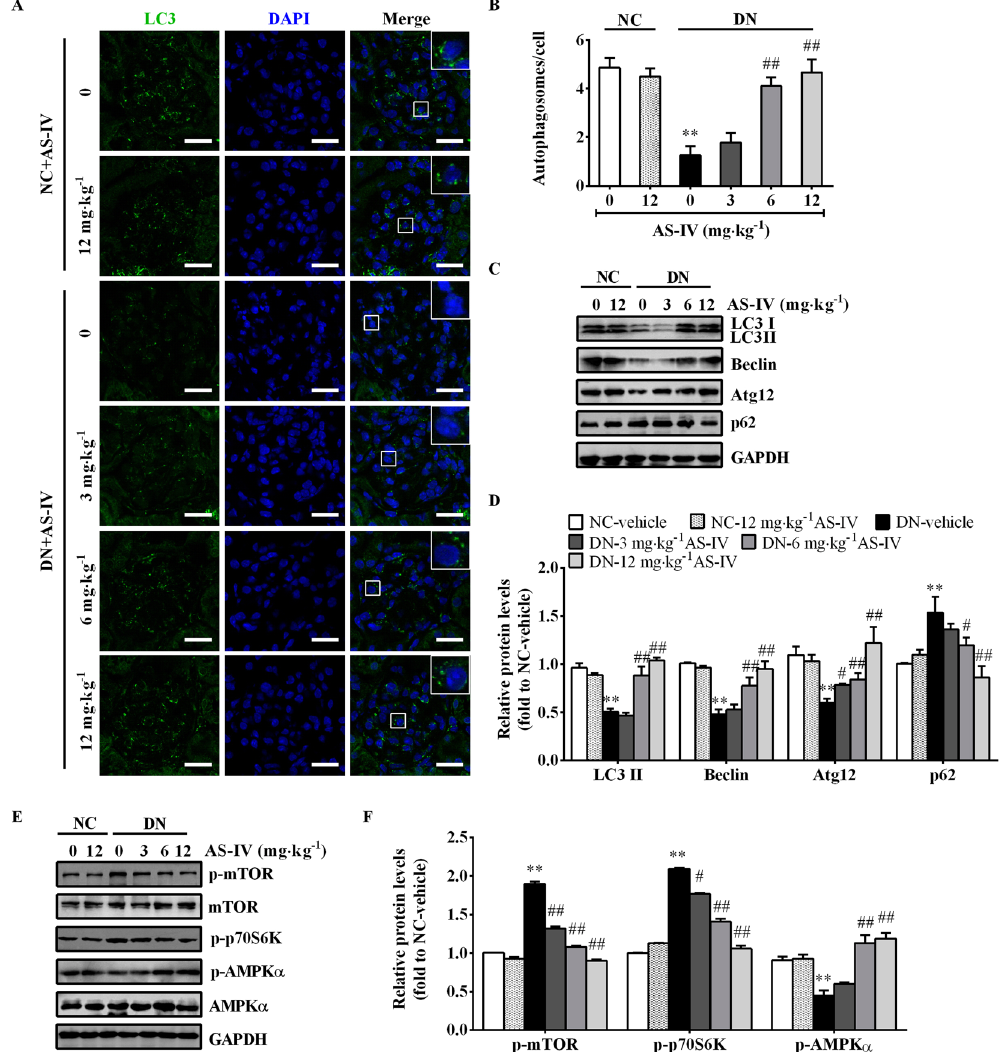
Figure 4. AS-IV repaired the defective autophagy in the glomeruli of STZ-induced diabetic mice. ( A ) Immunofluorescence staining for LC3B to examine autophagy activity in each group. Scale bars, 20 μ m. ( B ) Quantitative analysis of LC3-labeled autophagosomes per cell in the glomeruli of each group. ( C , D ) Western blot analyses ( C ) and densitometric quantification ( D ) of autophagy-related proteins such as LC3, Atg12, Beclin and p62 in the kidney cortex lysates from each group. ( E , F ) Western blot analyses ( E ) and densitometric quantification ( F ) of p-mTOR, p-p70S6K and p-AMPK α expression in total lysates of kidney cortex from each group. The original blots for panel C and E were presented in Supplementary Figure S5. Data are expressed as mean ± SEM. n = 4–6 per group. ** P < 0.01 compared to NC-vehicle group; # P < 0.05, ## P < 0.01 compared to DN-vehicle group. One-way ANOVA and Newman-Keuls multiple comparisons test ( B , D , F ). NC, non-diabetic control. DN, diabetic